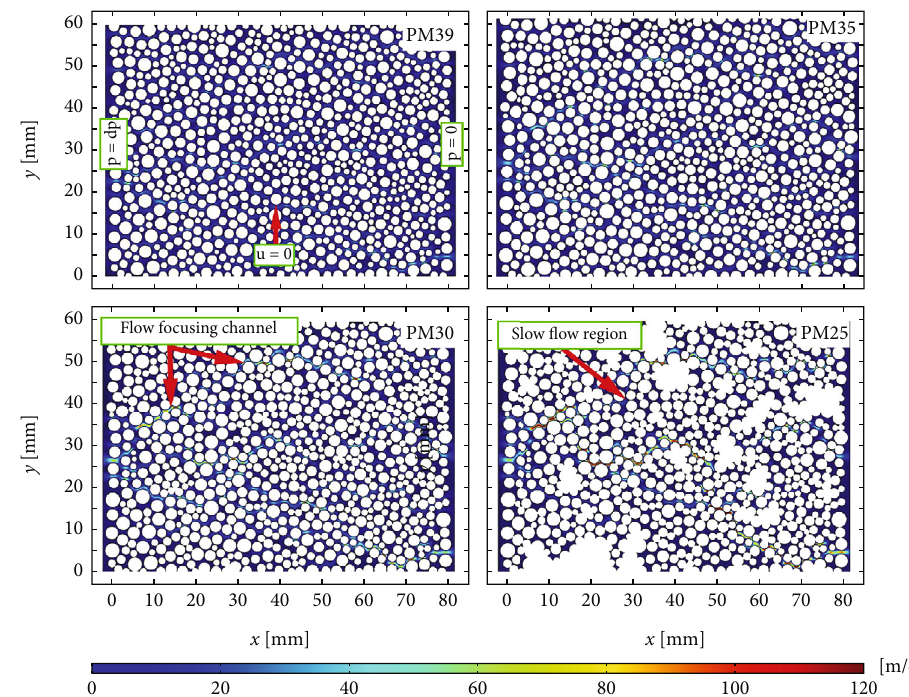
Figure 1: Details the porous media (Group 1) with di ff erent cementation degrees and the fl ow fi elds in the pore spaces. In the fi gure, the solid grains are represented by white circular shapes. The boundary conditions of the fl ow problems indicated in PM39 were also applied to the other media. The color coding indicates the fl uid fl ow velocities, with an average velocity of 10m/d in all of the porous media.